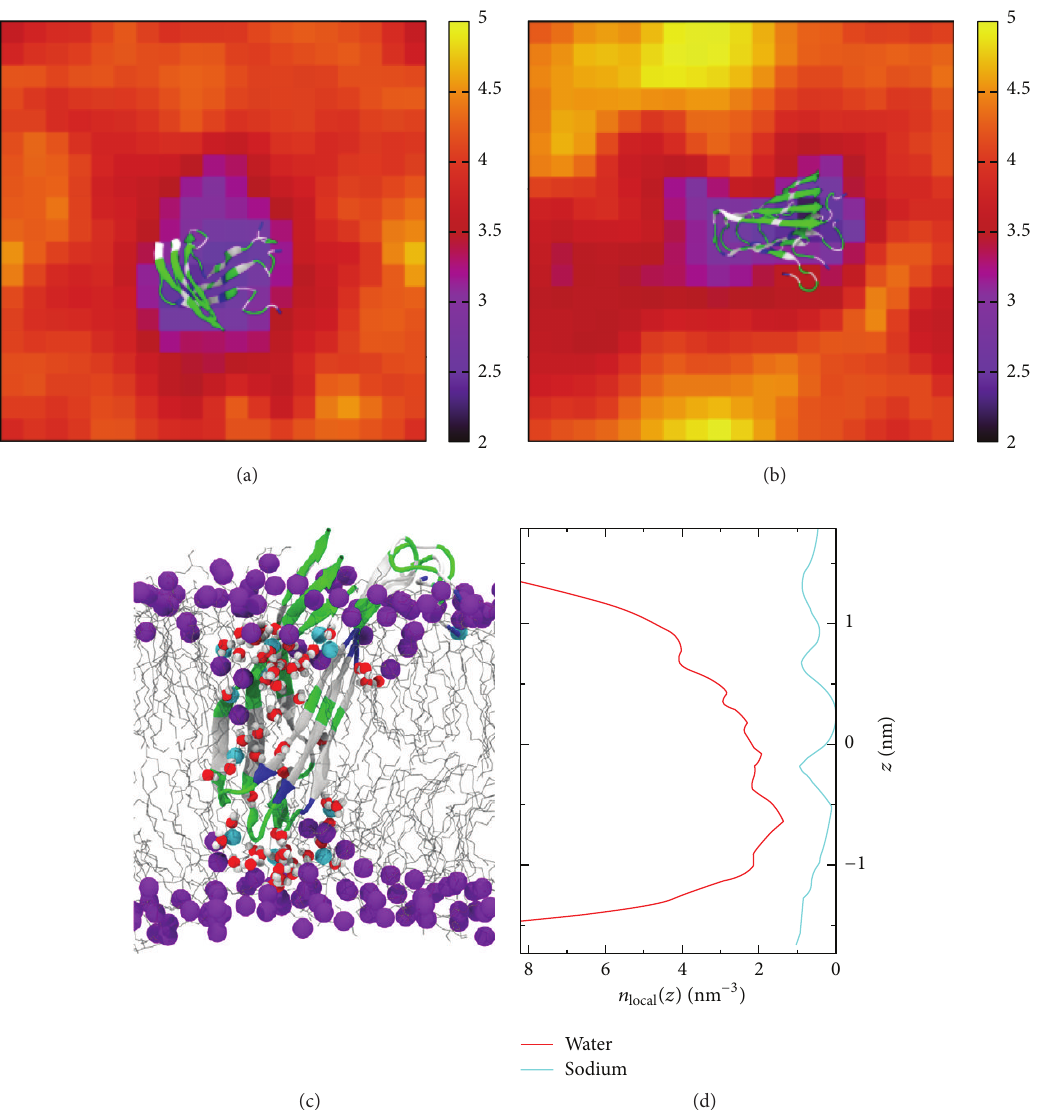
Figure 8: Bilayer thickness around embedded hIAPP for (a) trimer and (b) tetramer aggregates, as described by molecular dynamics simulations. Color key: bilayer thickness (in nm) is mapped to the corresponding colors. (c) Water channel formed by the hIAPP trimer in the DPPG bilayer, showing water molecules (red and white) and Na + ions (blue vdW spheres) percolating through the bilayer. (d) Average particle density of water and Na + ions within the membrane. Adapted from [14] with permission. Copyright 2013 by the Biophysical